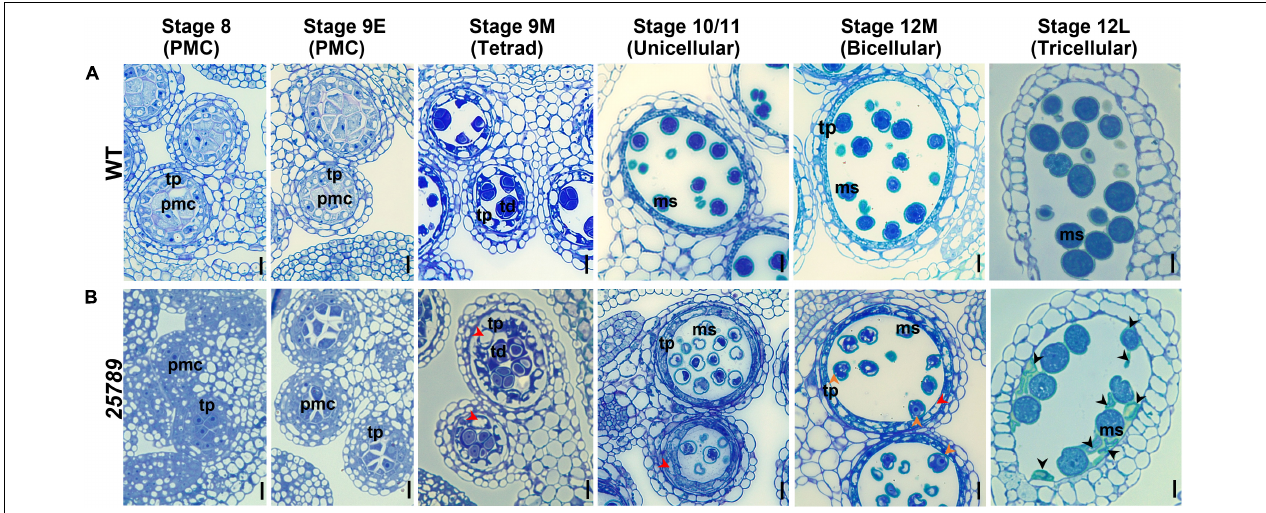
FIGURE 4 | Light and TEM micrographs reveal defects in pollen development in galt25789 Hyp-GALT quintuple mutant. Light micrographs of cross-sections of resin-embedded anthers of WT (A) and galt25789 quintuple (B) plants stained with toluidine blue. Developmental stages 8 to 12L of anthers along with corresponding pollen developmental stages are indicated at top. Red arrowheads in stages indicate vacuolated and thicker tapetal cell layer, as well as vacuolated pollen grains, at binucleate stage of the galt25789 mutant. Orange arrowheads indicate cytoplasmic shrinkage of pollen grains. Black arrowheads indicate cell wall debris of crushed pollen grains. Scale bar = 10 µ m. pmc-pollen mother cell; td-tetrad; tp-tapetum;